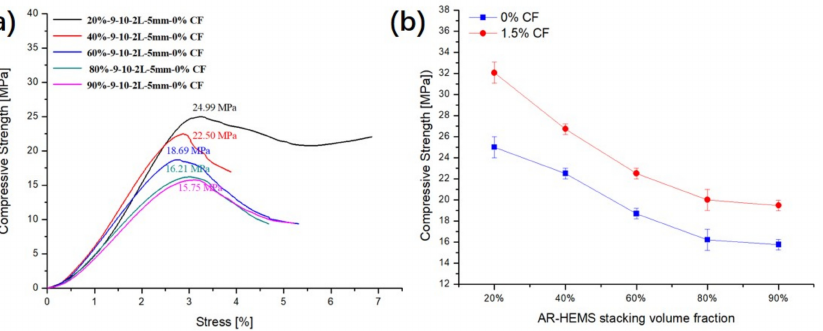
Figure 14. Influence of the addition of CF in EP-HGMS on the compressive properties of ESF with AR-HEMS with different stacking volume fractions.